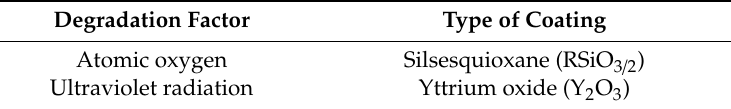
Table 1. List of protective coating applied to MM CF / PEEK samples.